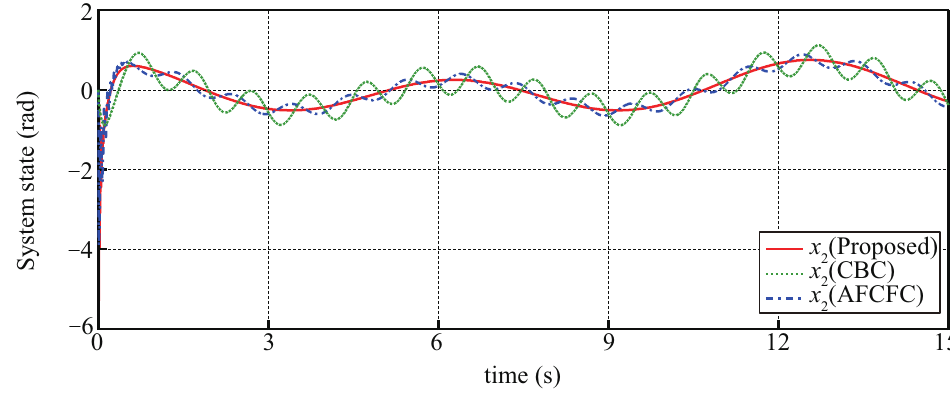
Figure 12. System state x 2 (the motor angle θ ) under the three